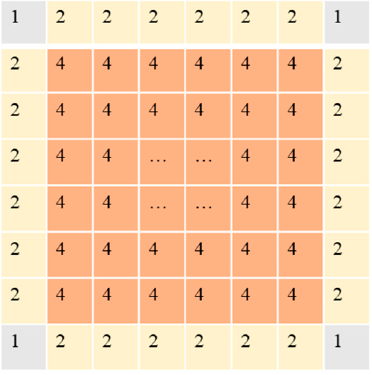
Figure 6. Prediction frequency diagram for the whole image. Each little square represents a region with 150 pixels × 150 pixels; the numbers in the squares are the numbers of predictions, which are treated as weights to calculate the final poppy confidence.